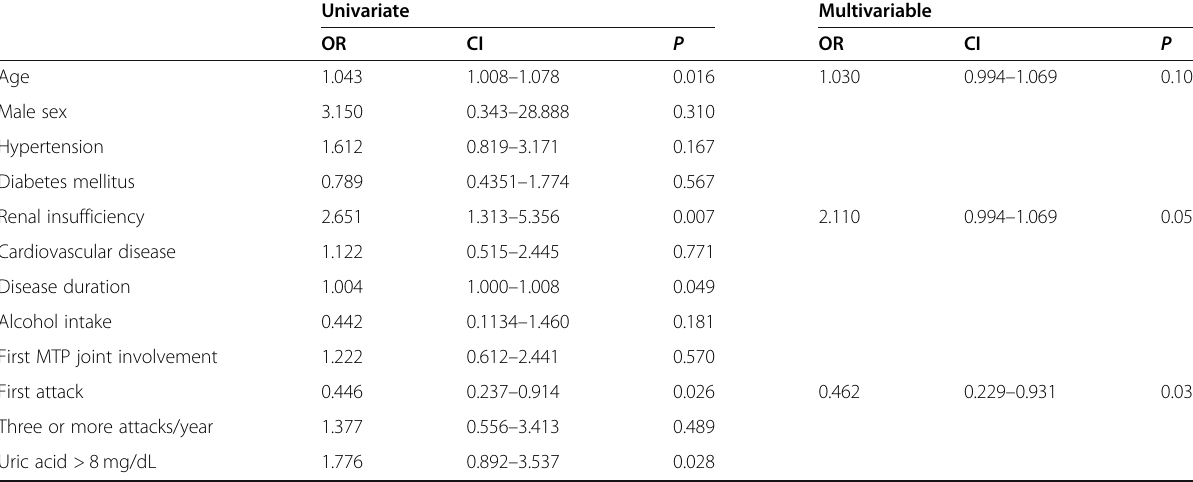
Table 2 Factors associated with dual-energy computed tomography